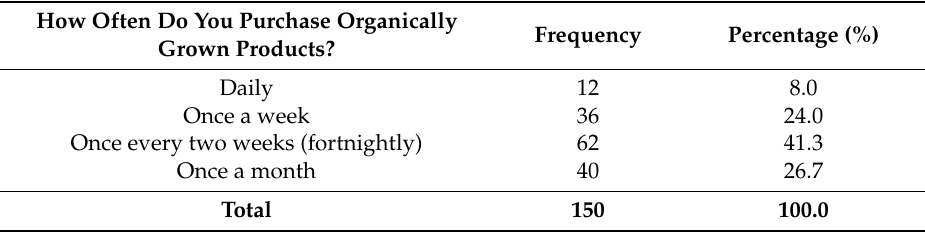
Table 7. The frequency of purchasing organically grown products by the interviewed consumers in Shelly Centre (n =